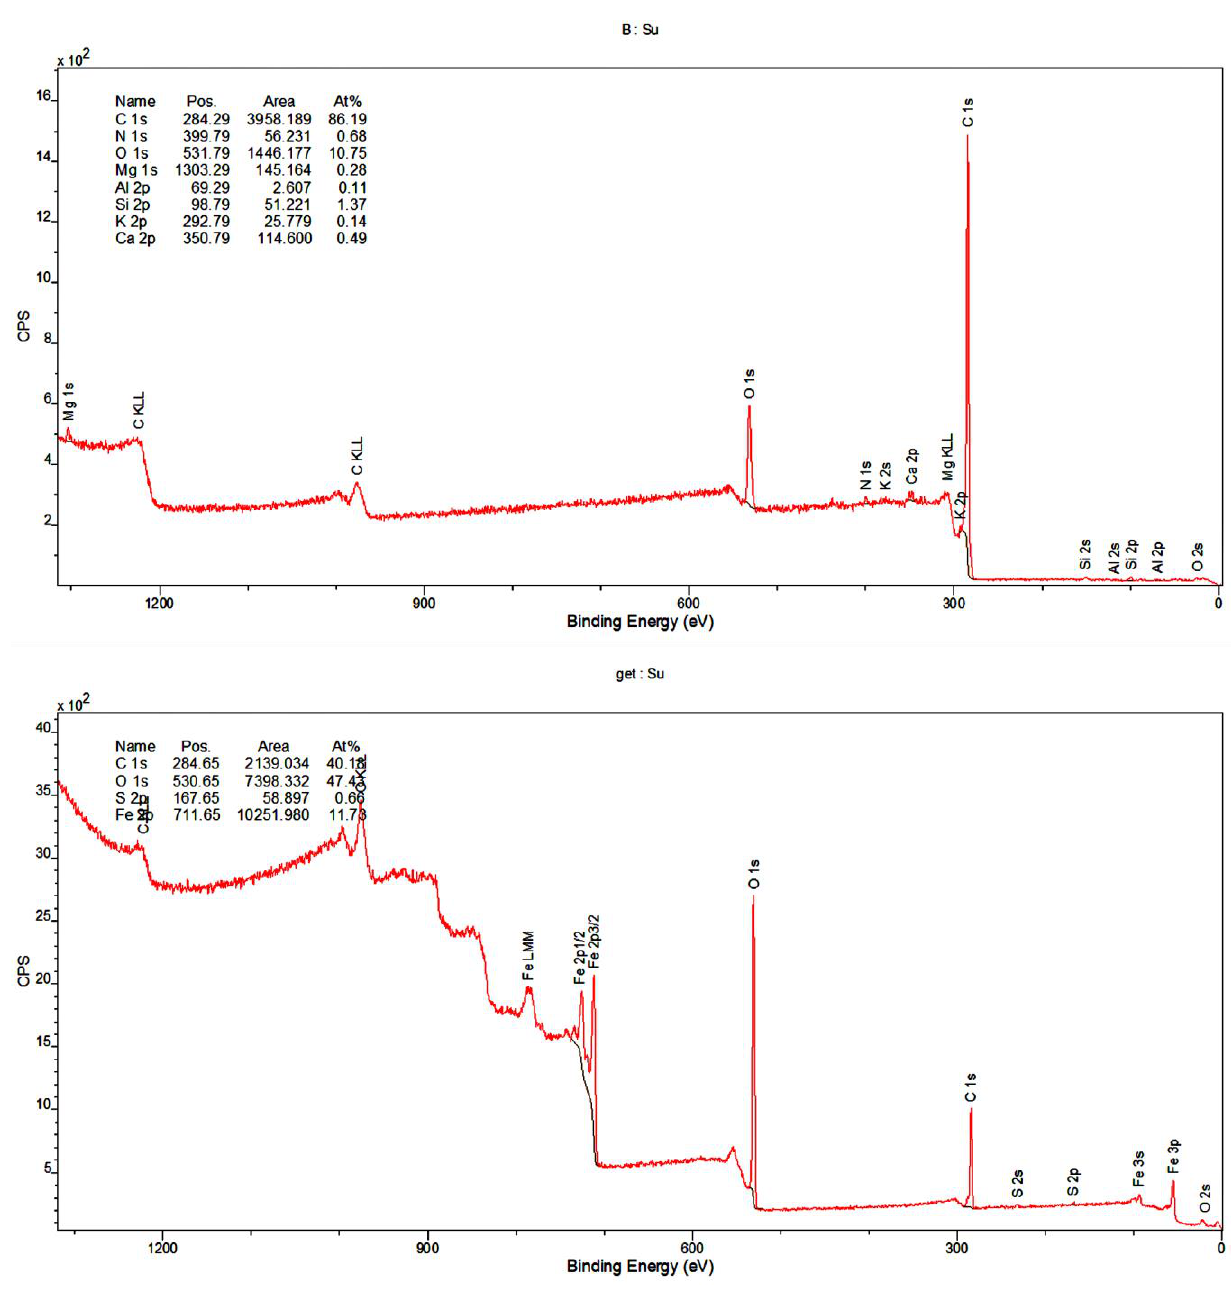
Figure 3. Survey XPS spectra for biochar (B) and goethite (get). Table 2. O1s XPS data obtained for goethite and biochar.